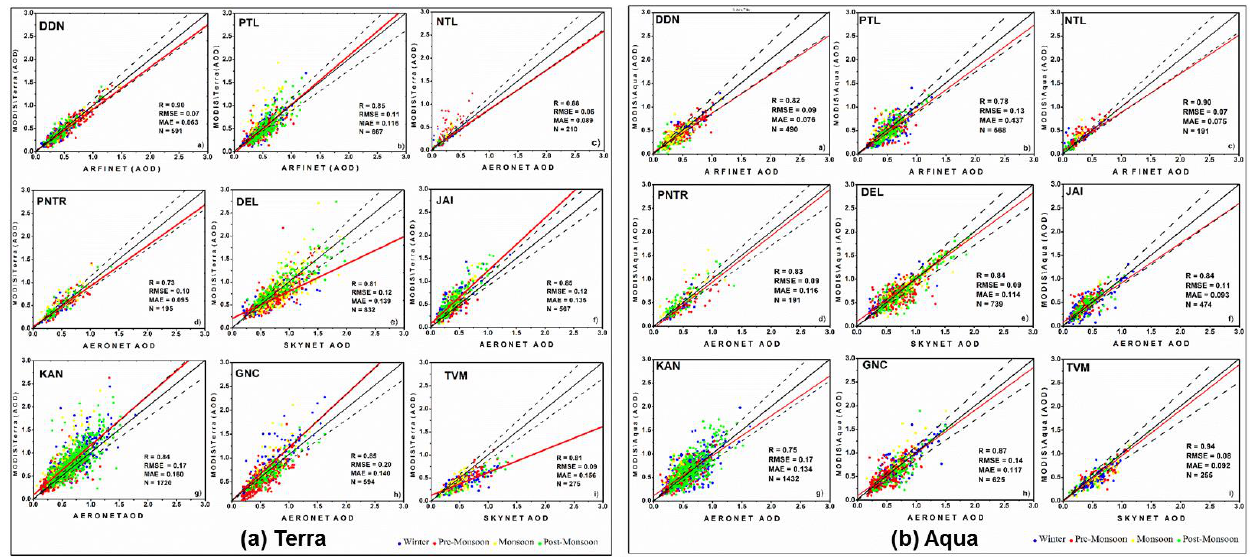
Figure 4. Scatter plot of MODIS DT 3-km daily AOD against ground measured AOD at nine stations across India (a) Terra and (b) Aqua. The red solid line represents ‘regression line’, the dash lines stand for the MODIS ‘Expected error lines’, and the black solid line is ‘1:1 line’. The colour code represents the daily AODs with corresponding seasons.